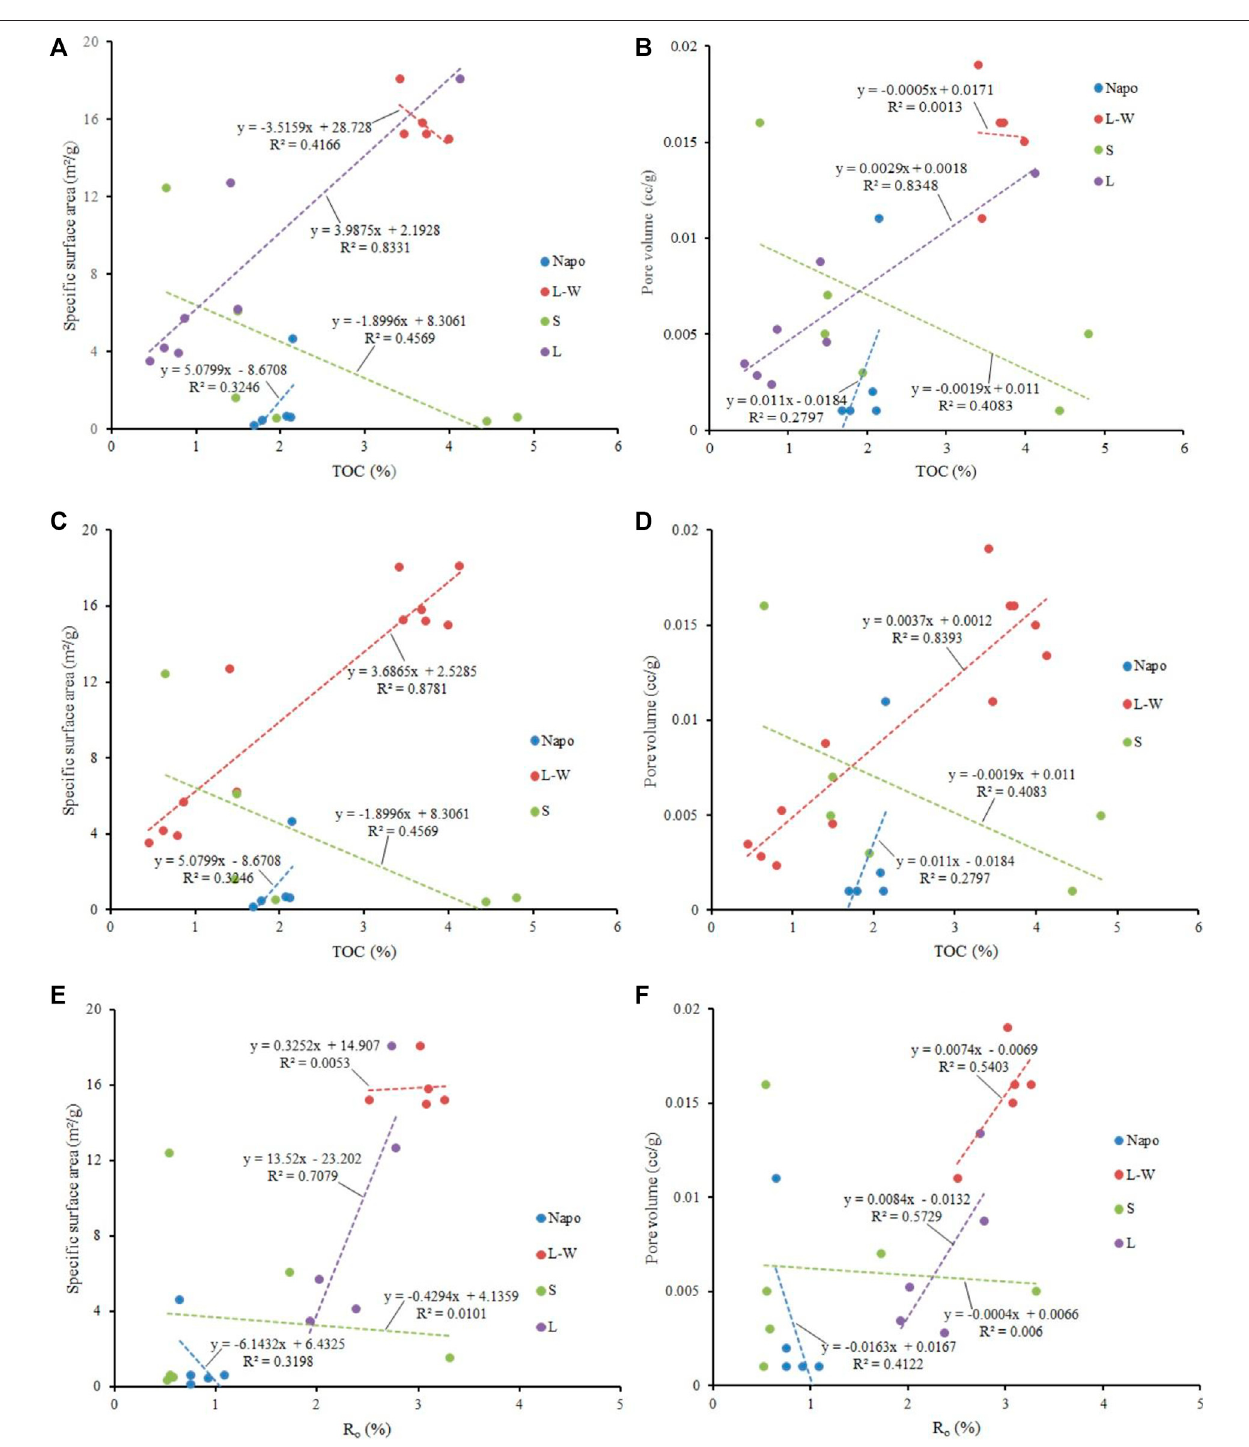
FIGURE 10 | Relationship between pore structure parameters and TOC content and R o of the shale samples. Notes: (A) Correlation between TOC content and speci fi c surface area; (B) Correlation between TOC content and pore volume; (C) Correlation between TOC content and speci fi c surface area; (D) Correlation between TOC content and pore volume; (E) Correlation between R o and speci fi c surface area; (F) Correlation between R o and pore volume; “ Napo ” - Napo Formation shale samples; “ S ” -ShahejieFormationshalesamples; “ L-W ” -LongmaxiandWufengFormationshalesamples; “ L ” -LongmaxiFormationshaledatafromJietal.,2016.